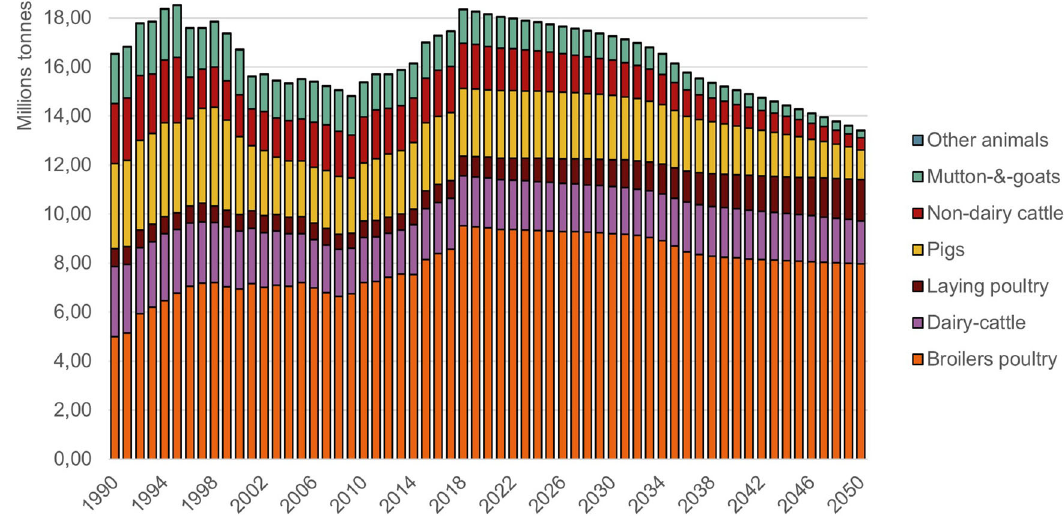
Fig. 2 Slaughtered/producing livestock in the UK from 1990 to 2050 in the EEB pathway (lsu) 1,27,43 . Slaughtered livestock refers to the animals slaughtered per year, while producing livestock refers to living animals (e.g. dairy